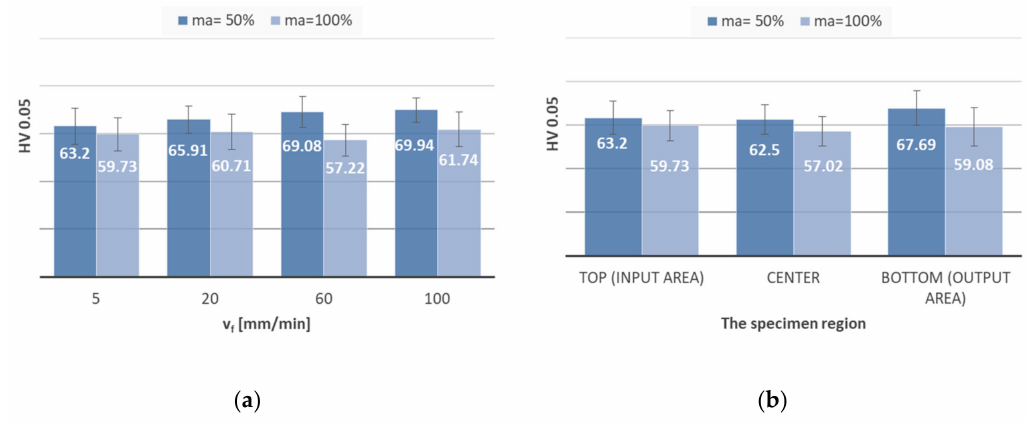
Figure 8. Microhardness: ( a ) with variable jet feed rate v f and ( b ) in di ff erent specimen region v f = 5 mm /